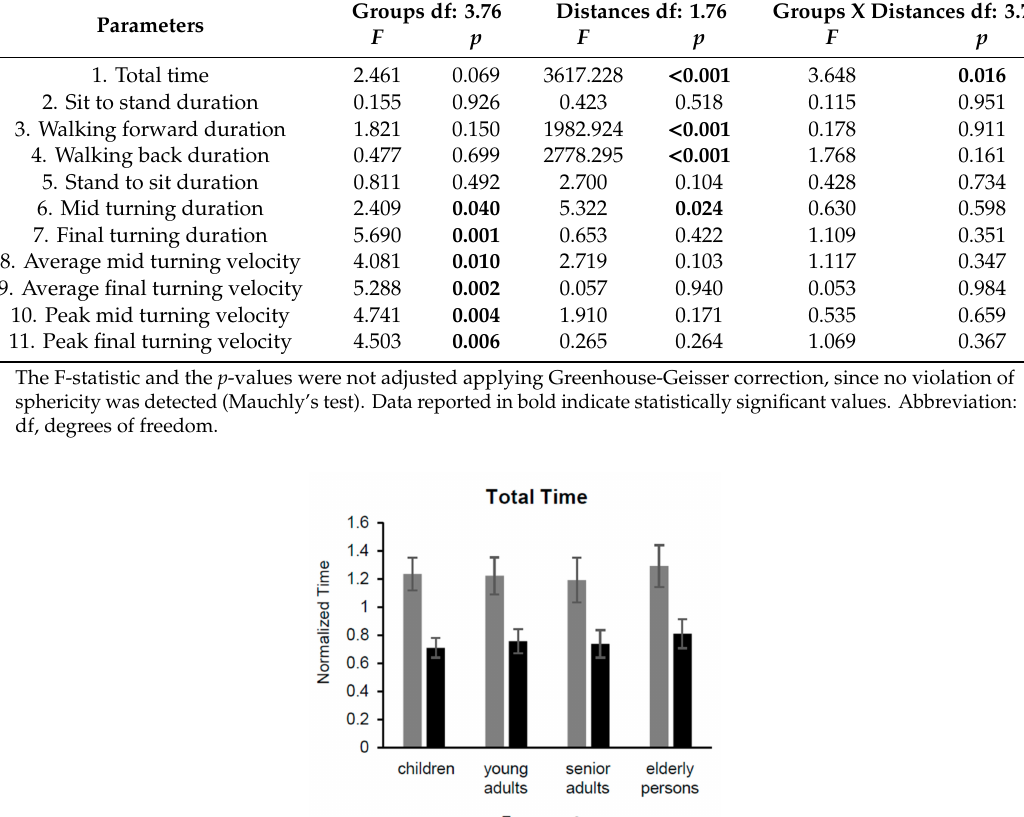
Table 4. Summary of the two-way analysis of variance; df—degrees of freedom. Groups df: 3.76 Parameters